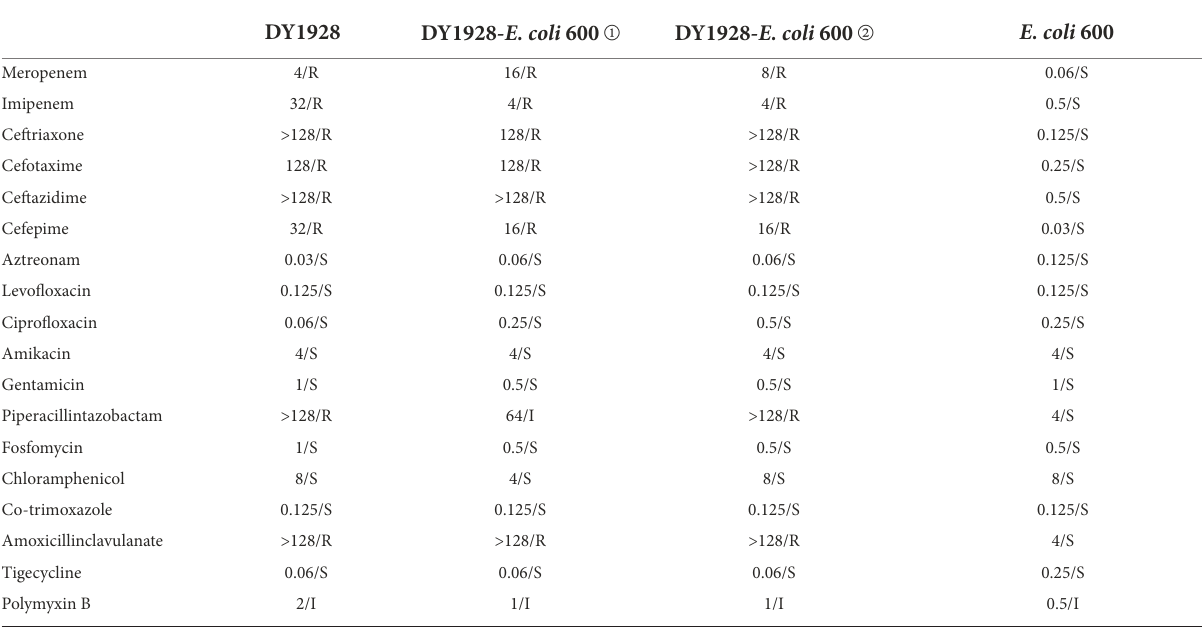
TABLE 1 MICs of DY1928, transconjugants and E. coli 600.